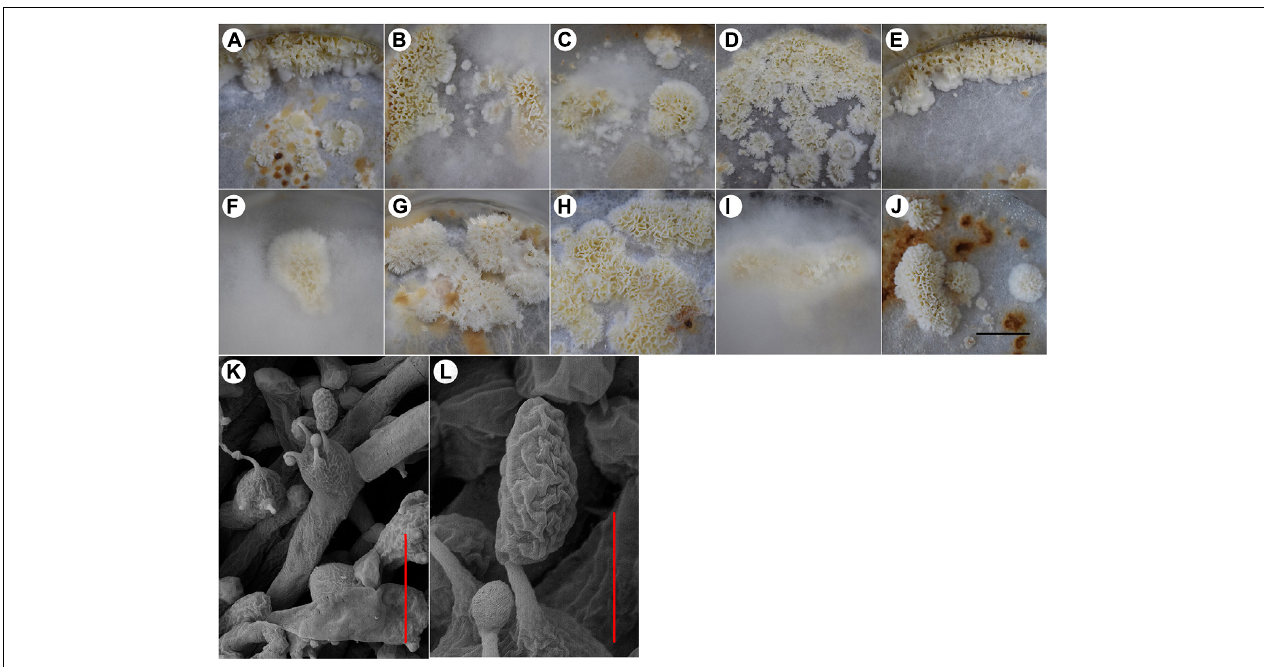
FIGURE 1 | The fruiting bodies of different W. cocos strains. (A) strain 5.78, (B) strain Z1, (C) strain CGMCC 5.137, (D) strain CGMCC 5.157, (E) strain CGMCC 5.908, (F) strain CGMCC 5.55, (G) strain NBRC 30628, (H) strain CGMCC 5.545, (I) strain 28-1, (J) strain CGMCC 5.2216, (K) basidia of strain CGMCC 5.545, and (L) basidiospores of strain CGMCC 5.545. Scale bars: A–J = 2 cm, K: 10 µ m, and L: 3 µ m.